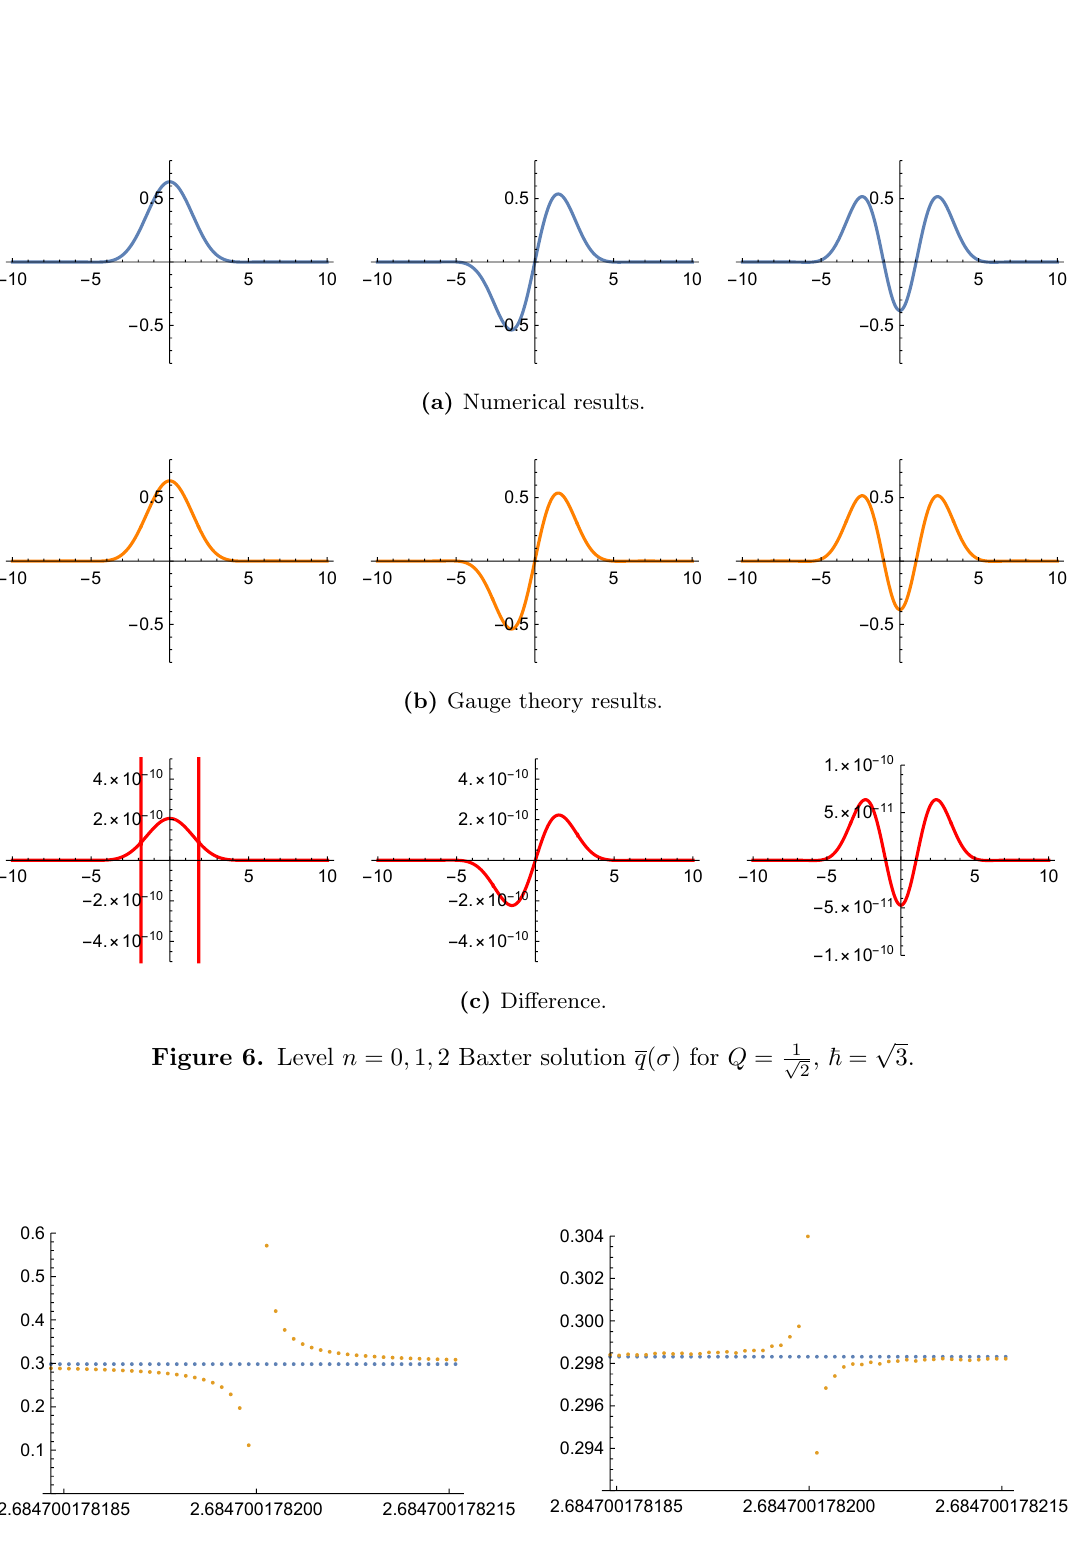
Figure 7. Level n = 1 numerical (blue dots) and gauge theory (orange dots) Baxter solution q ( (cid:27) ) p for Q = 1 p , ~ = 3 near (cid:27) = a (1) . Left: 4-instanton results; right: 6-instanton results. 2